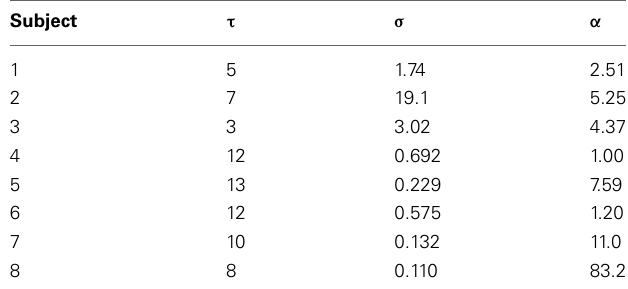
Table 2 | Estimated model parameter values corresponding to scaling exponents of the data in Figure